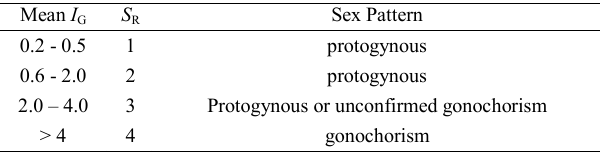
Table 1. I of breeding males, sperm competition ranks ( S G and sexual pattern of groupers species according to review by Erisman et al. (2009). S (1), non aggregating species that R spawn in pairs; S (2), aggregating species that spawn in R pairs; S (3), aggregating species that spawn in pairs or R groups; S (4), aggregating species that spawn only in R